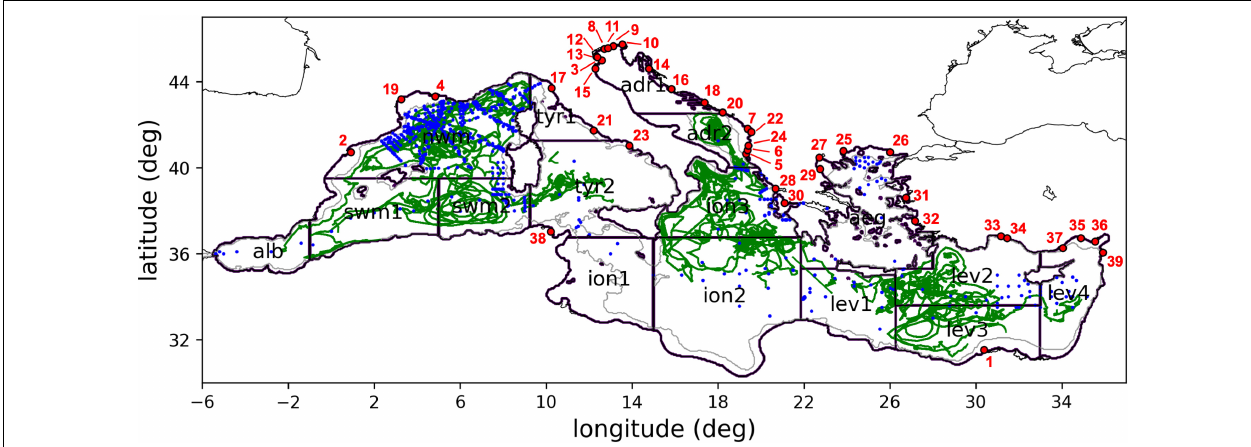
FIGURE 1 | Subdivision of the model domain in sub-basins used for the validation of the reanalysis. According to data availability and to ensure consistency and robustness of the metrics, different subsets of the sub-basins or some combinations among them can be used for the different metrics: lev = lev1 + lev2 + lev3 + lev4; ion = ion1 + ion2 + ion3; tyr = tyr1 + tyr2; adr = adr1 + adr2; swm = swm1 + swm2. The gray line defines the bathymetric contour at 200 m. Blue dots represent open sea observations of nitrate from EMODnet_int data collection (period 1999–2016). Green lines correspond to trajectories of BGC-Argo floats with chlorophyll observations (period 2013–2018). Red dots with numbers correspond to main river mouth positions: Nile (1), Ebro (2), Po (3), Rhone (4), Vjosë (5), Seman (6), Buna/Bojana (7), Piave (8), Tagliamento (9), Soˇca/Isonzo (10), Livenza (11), Brenta-Bacchiglione (12), Adige (13), Lika (14), Reno (15), Krka (16), Arno (17), Nerveta (18), Aude (19), Trebisjnica (20), Tevere (21), Mati (22), Volturno (23), Shkumbini (24), Struma/Strymonas (25), Meric/Evros/Maritsa (26), Axios/Vadar (27), Arachtos (28), Pinios (29), Acheloos (30), Gediz (31), Buyuk Menderes (32), Kopru (33), Manavgat (34), Seyhan (35), Ceyhan (36), Gosku (37), Medjerda (38), Asi/Orontes (39).